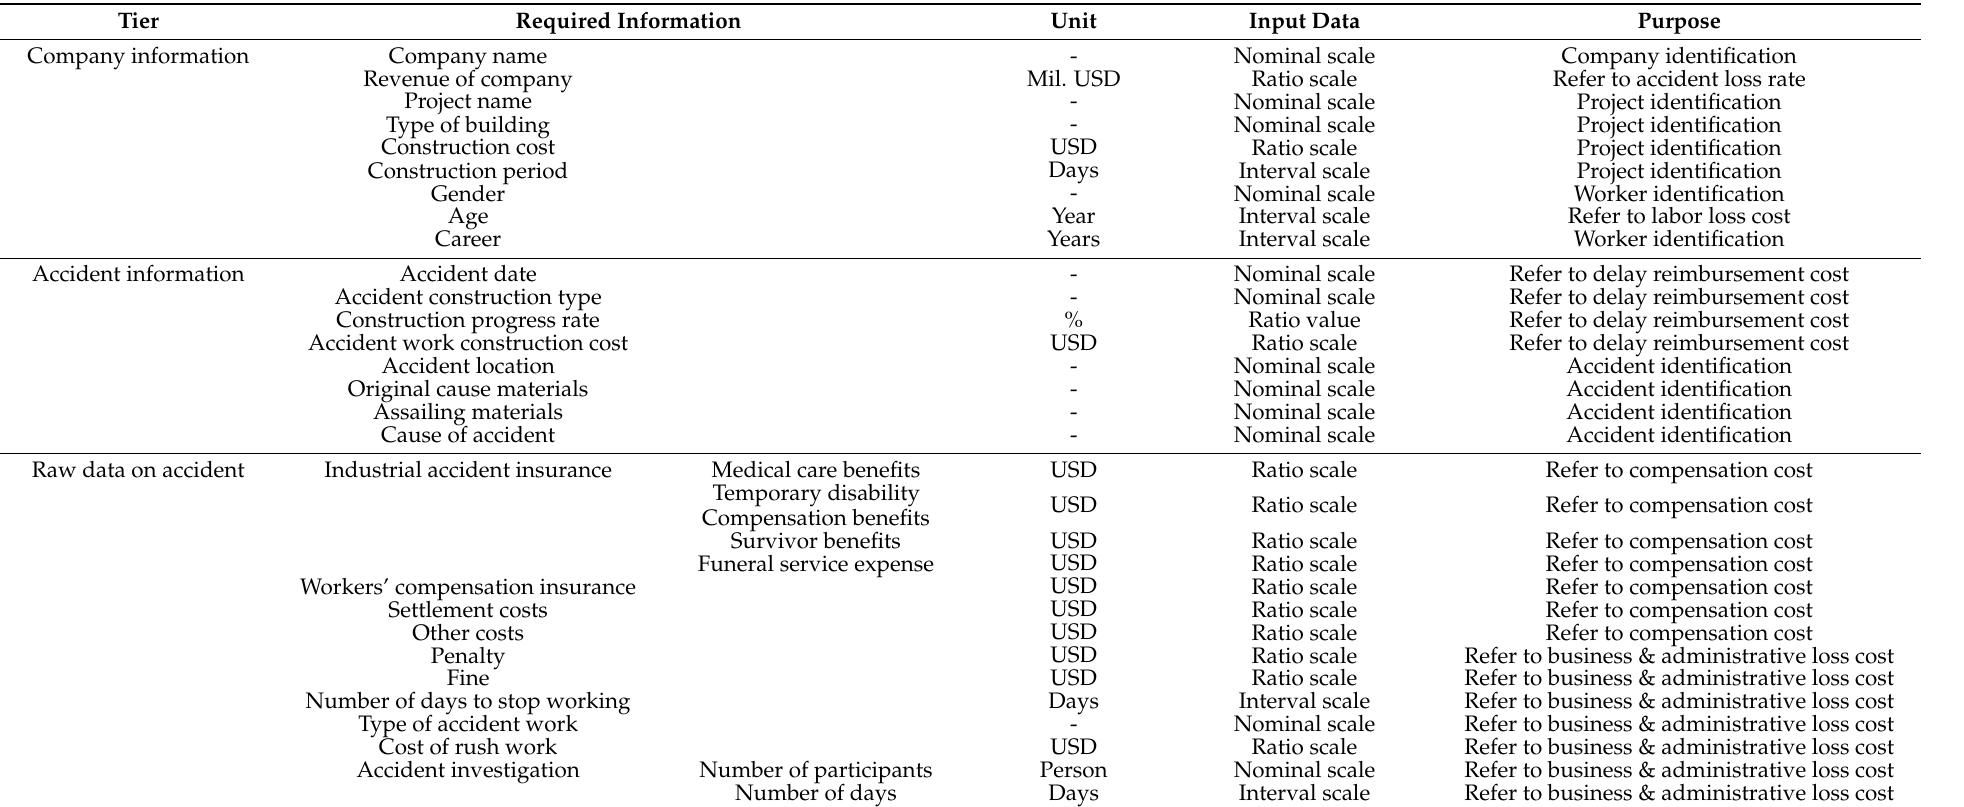
Table 2. Information for survey based on the proposed